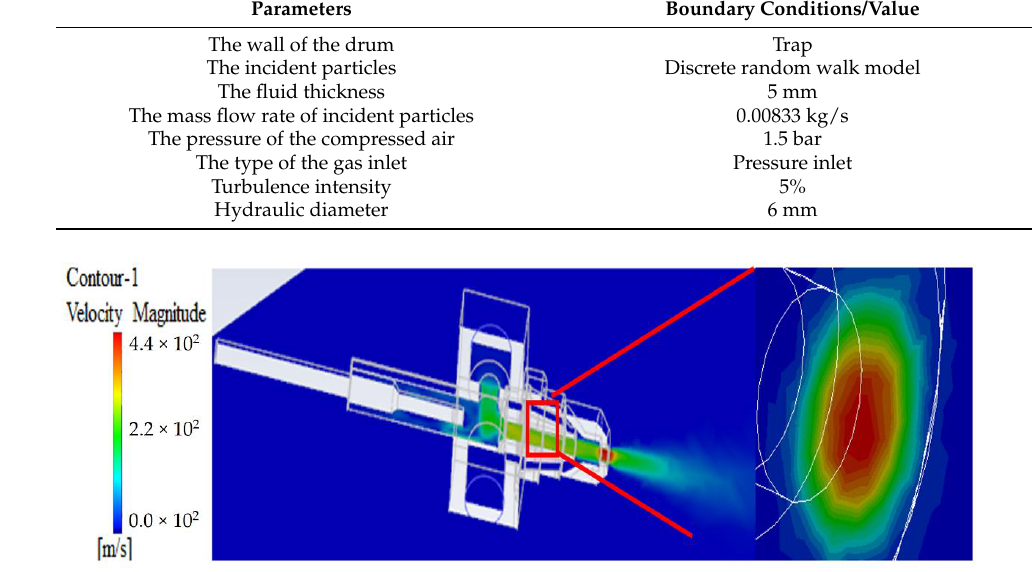
Figure 4. Velocity contour under 1.5 bar of compressed air.